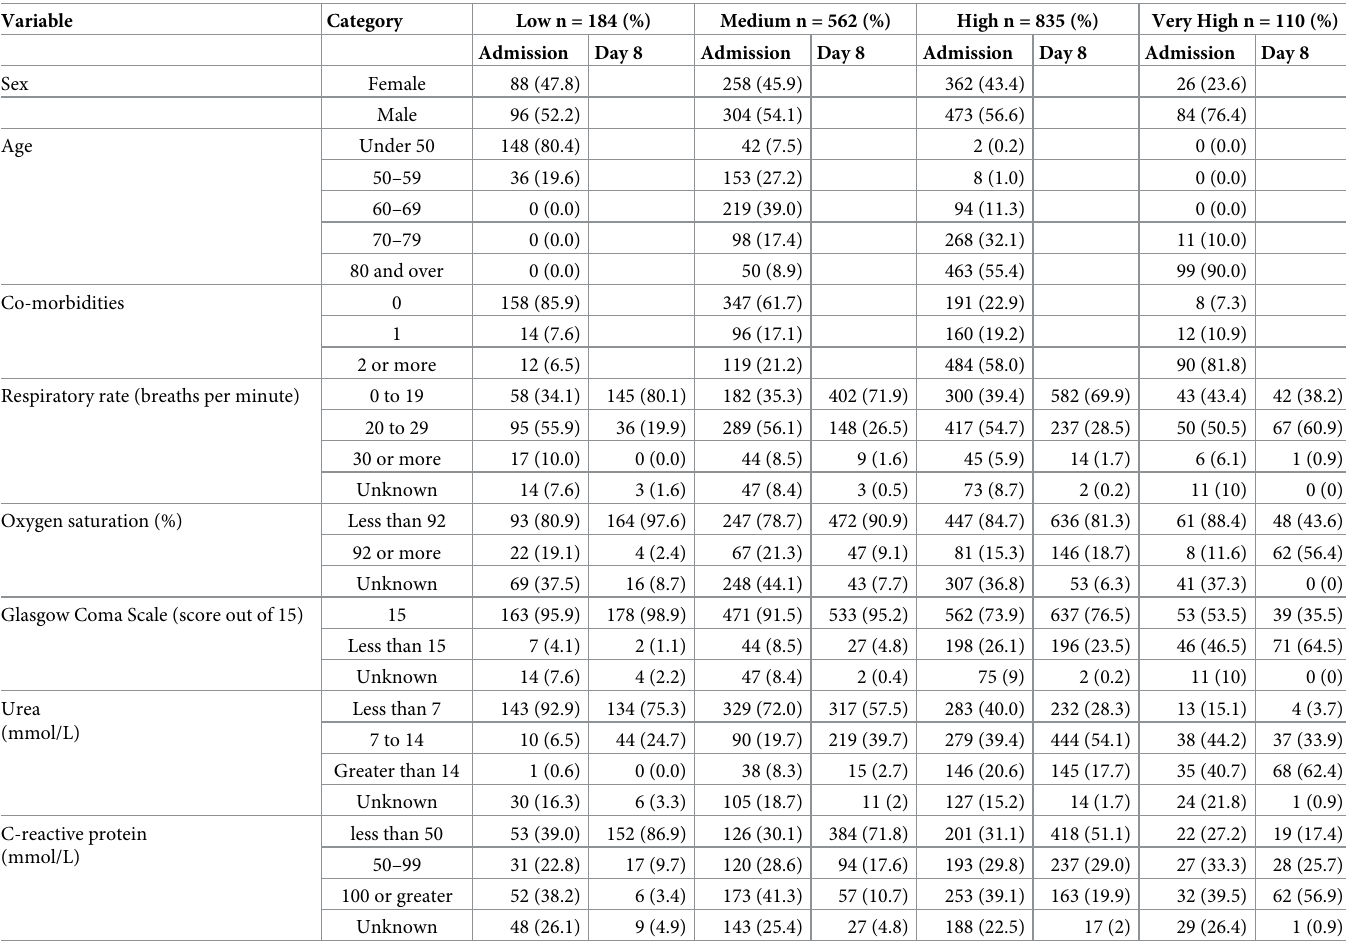
Table 5. Summary statistics on score components by risk group at day 8 showing values at baseline on admission and at day 8. Risk groups: Low (0–3), intermediate (4–8), high (9–14) and very high (15+).